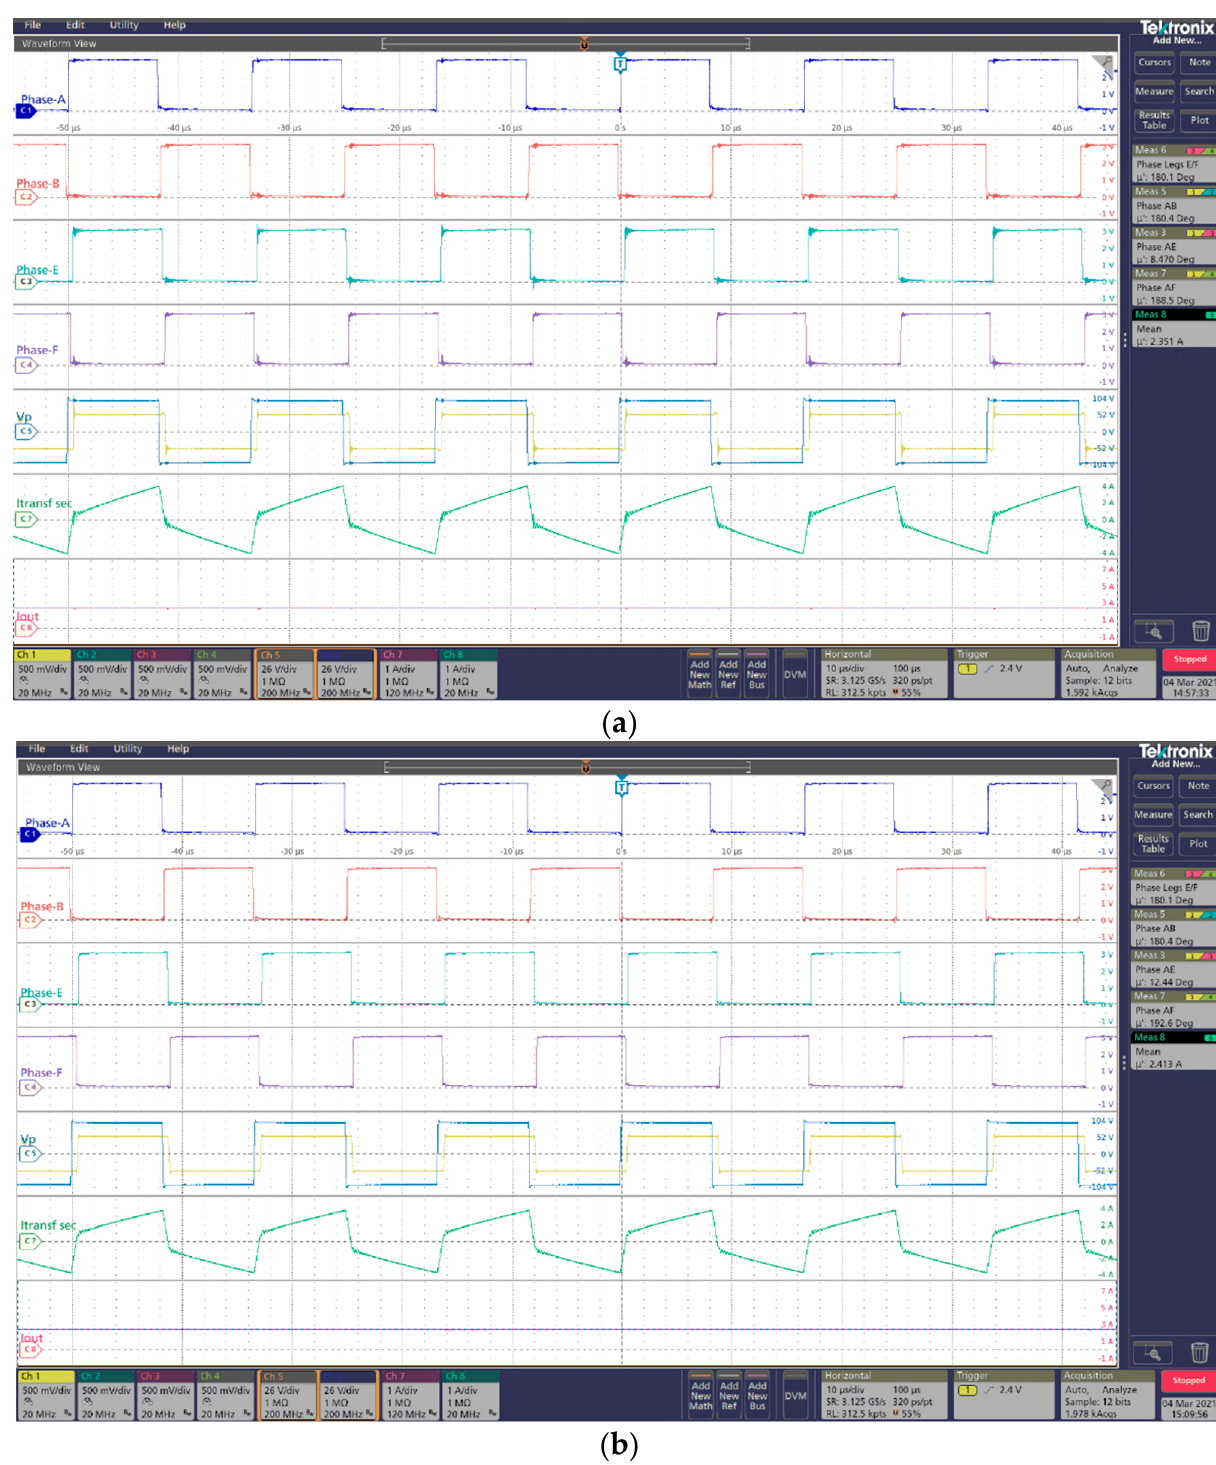
Figure 15. Gate control signals, transformer’s primary and secondary voltage, inductor current and output current average of the experimental model at 60 kHz: ( a ) Case 2; ( b ) Case 3.